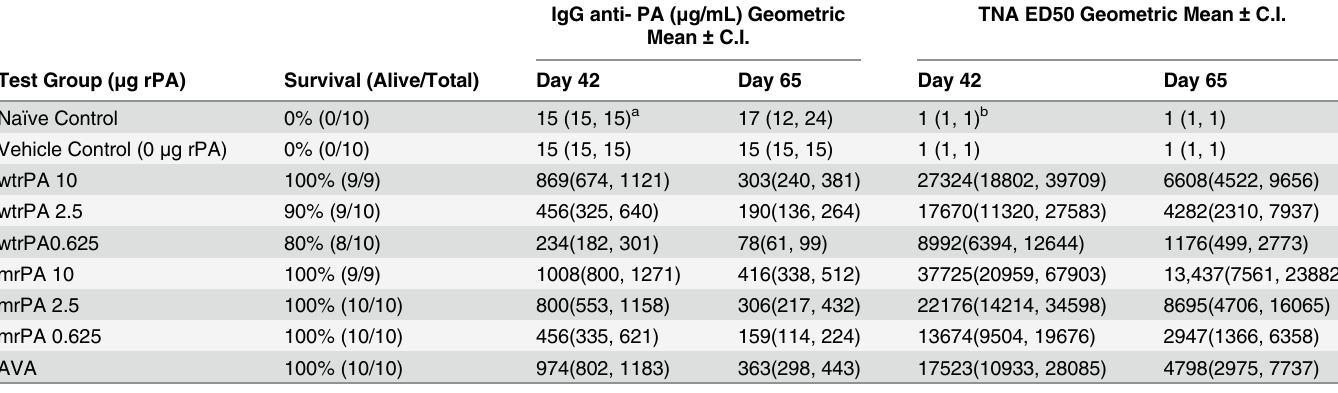
Table 3. Study Summary of Fate and Immune Status Relevant to B. anthracis Challenge on Day 70.